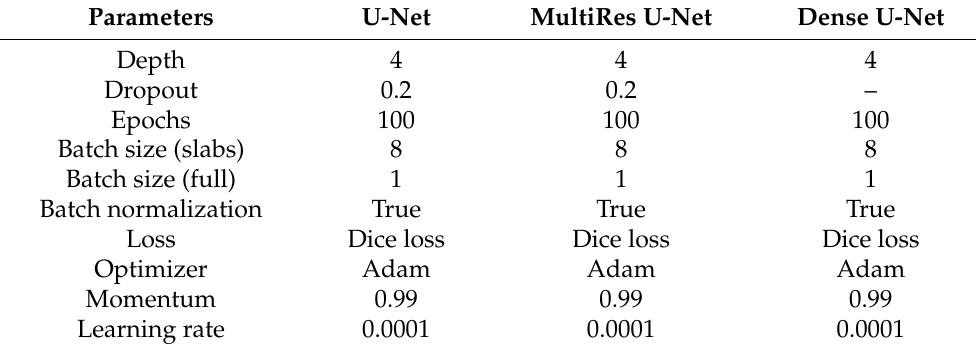
Table 1. Model parameters on slabs and full volume.